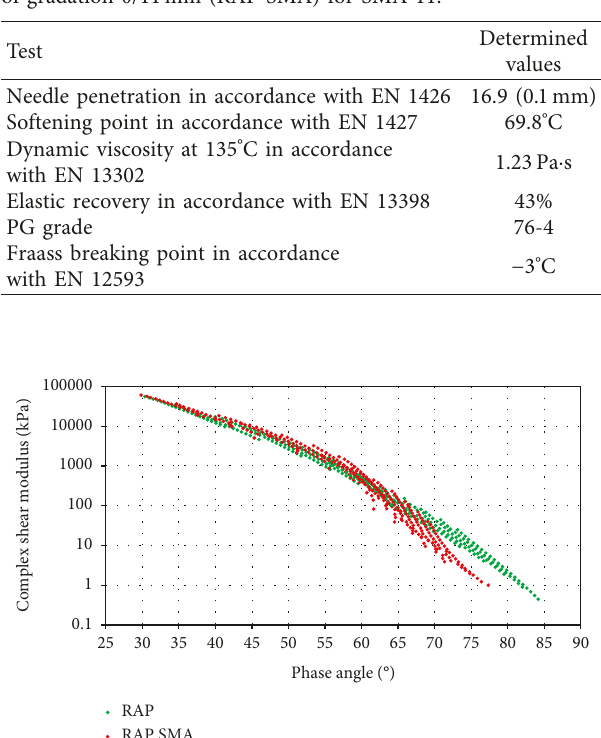
Table 3: Basic properties determined for reclaimed binder from RA